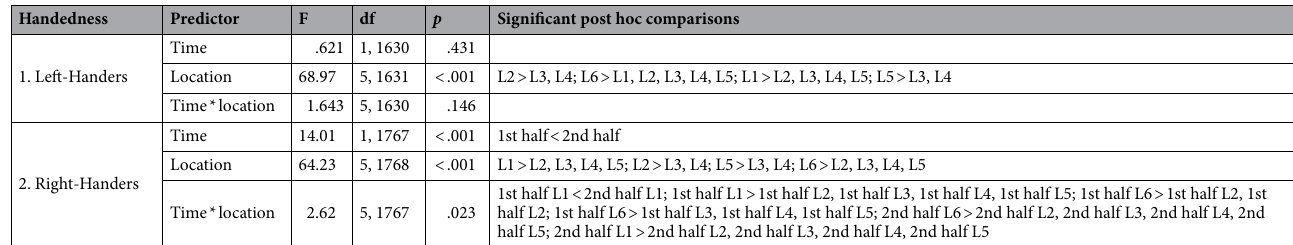
Table 3. F values, degrees of freedom, p values and holm corrected post hoc comparisons with corrections relative to time-on-task and location separated by handedness for models with the outcome reaction time. For post hoc analyses < and > indicate the direction of the effect. For example, L2 > L3 reflects higher reaction time at location 2 compared to location 3. Only relevant post hoc comparisons reaching statistical significance ( p < .05) following corrections for multiple comparisons are reported for